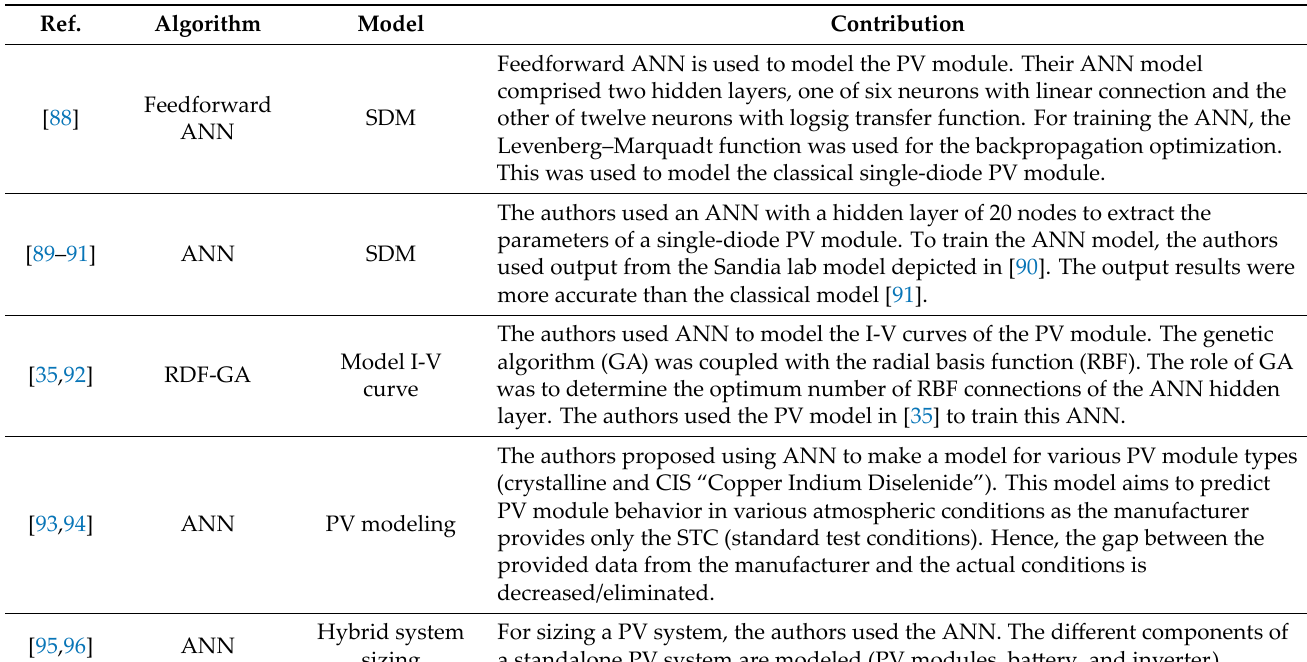
Table 5. Soft computing algorithms—artificial neural networks.